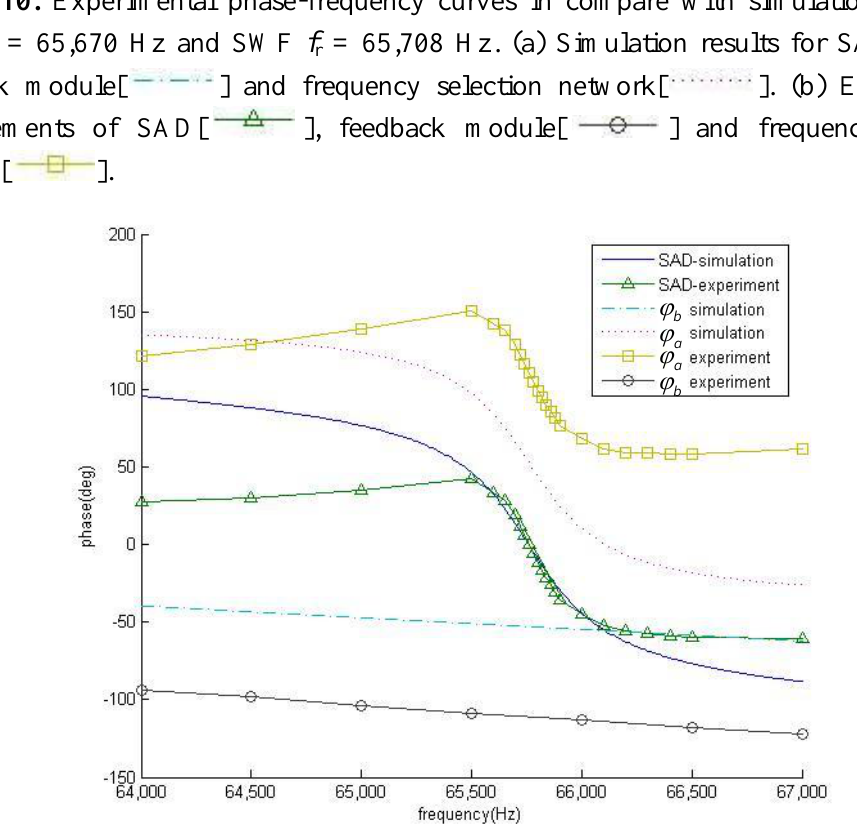
Figure 10. Experimental phase-frequency curves in compare with simulation results